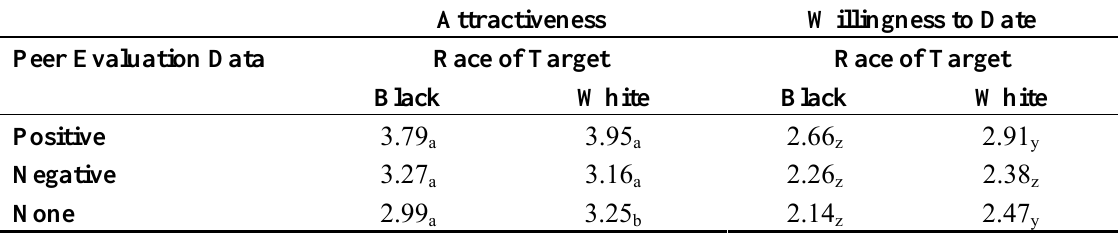
Table 3. Least square means for ratings of attractiveness and willingness to date by type of peer evaluation data and target